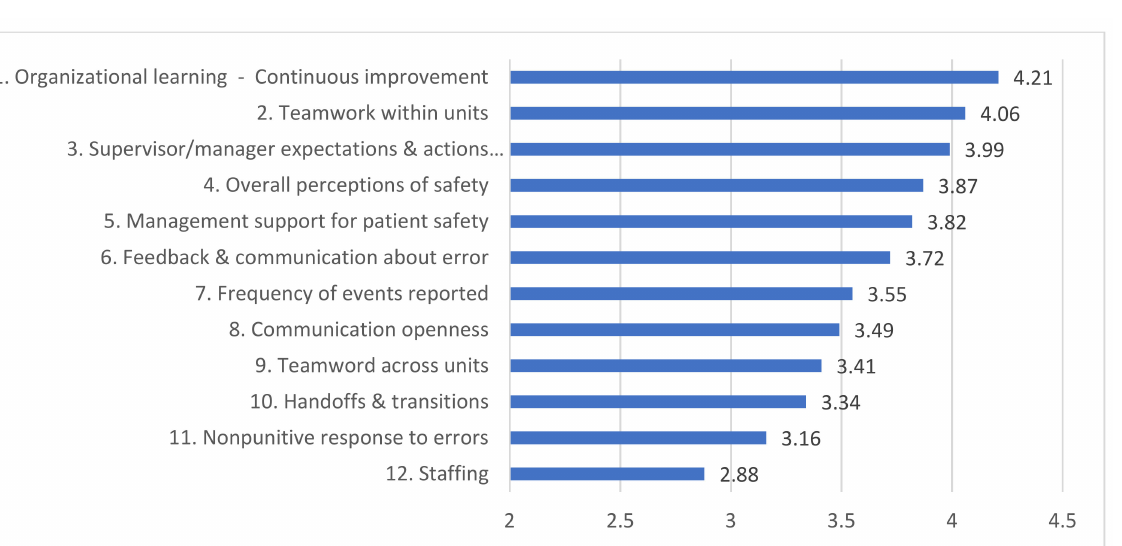
For nine dimensions, the mean scores were between “neutral” attitude and “agree- ment”. Two dimensions, “Teamwork within units” (4.06 ± 0.72) and “Organizational being associated with a positive attitude of “agreement”. “General perceptions of patient